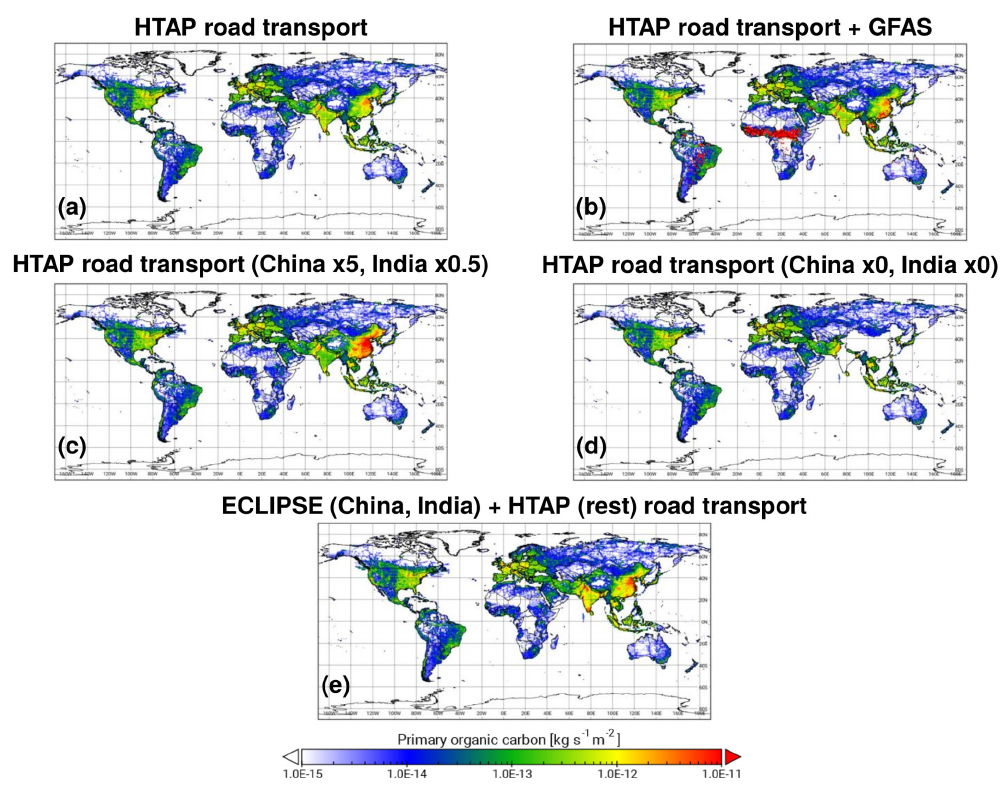
Figure 2. Examples of organic carbon global emission outputs regridded onto a 0 . 5 ◦ × 0 . 7 ◦ global regular lat–long domain obtained with HERMESv3_GR using five different versions of the emission inventory configuration file: HTAP road transport (a) , HTAP road trans- port + GFAS (b) , HTAP road transport with scaling factors over China (5) and India (0.5) (c) , HTAP road transport masking out China and India (d) , and ECLIPSE road transport (China and India) + HTAP road transport (rest of countries) (e) . The corresponding emission inventory configuration files used in each example are shown at the